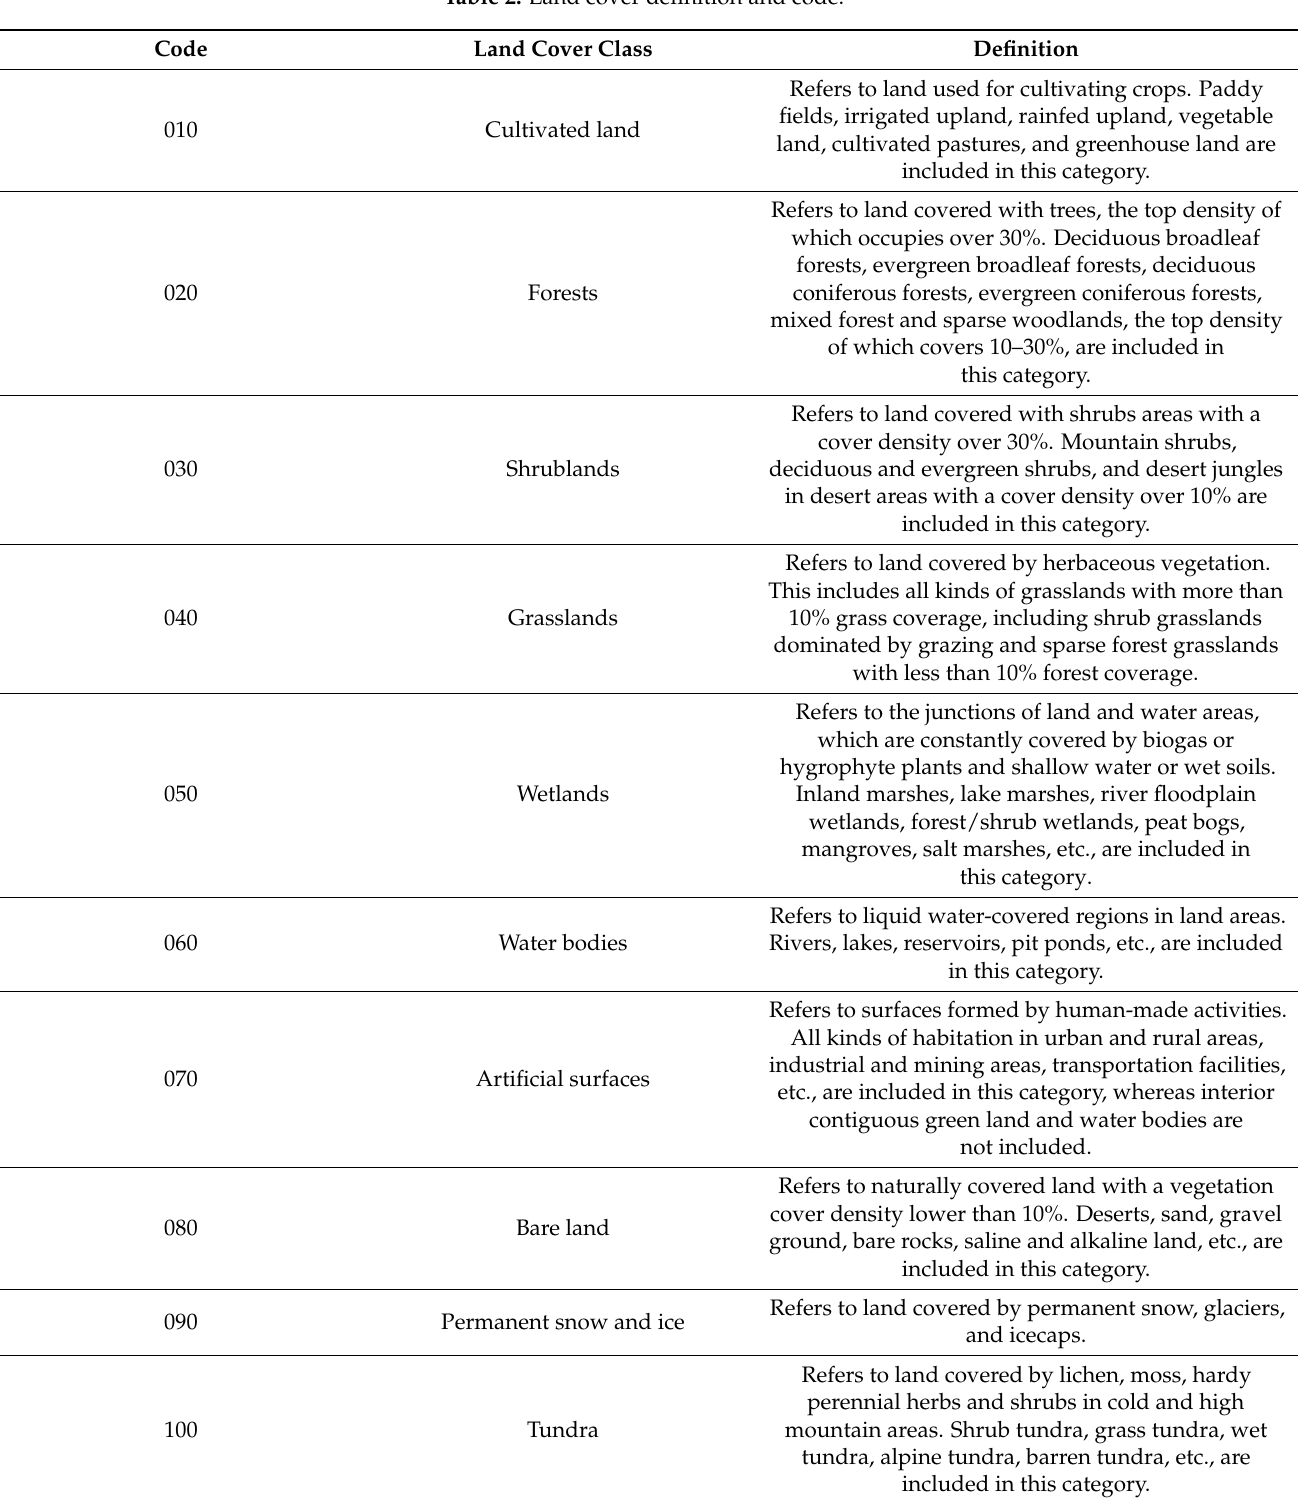
Table 2. Land cover definition and